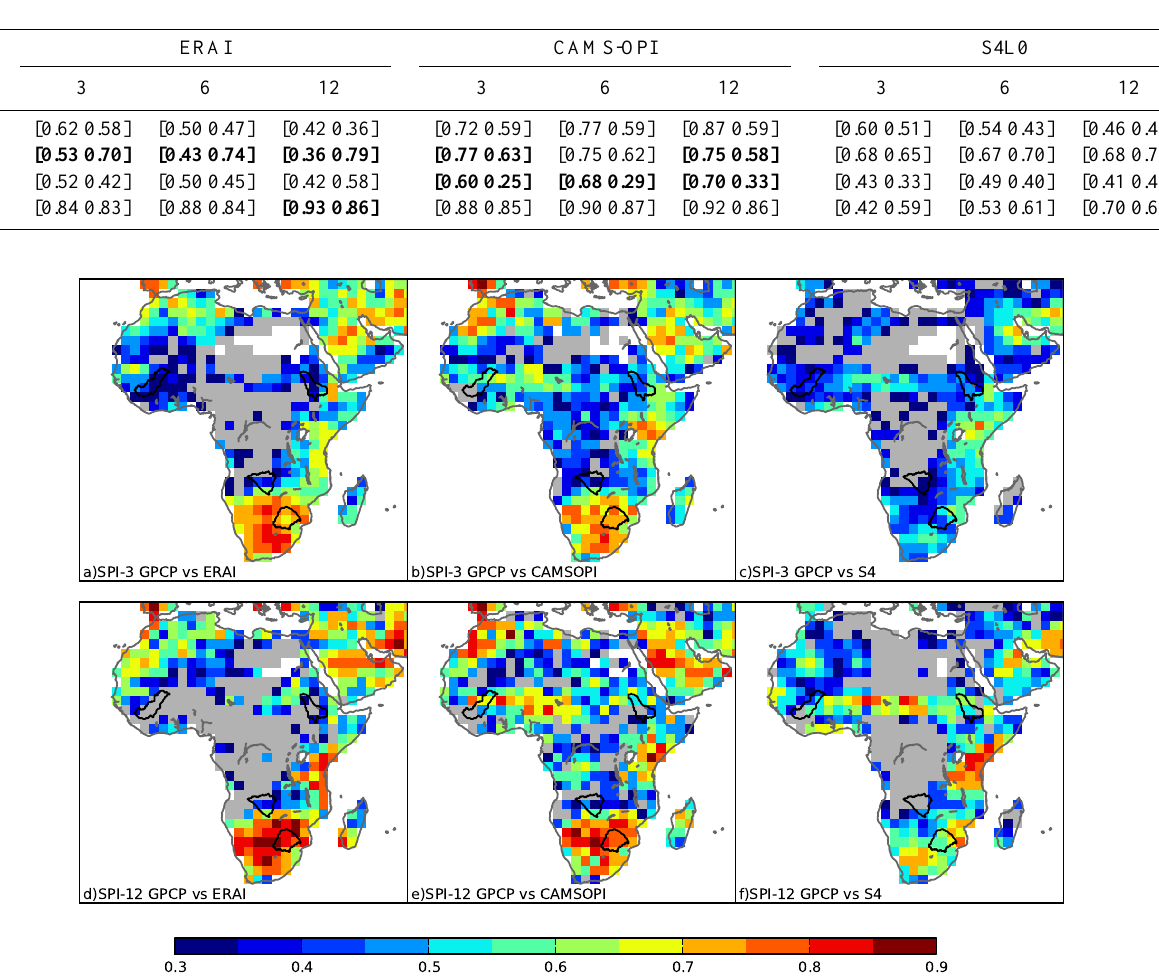
Table 3. Temporal correlation of the GPCP 3-, 6- and 12-month SPI and ERAI, CAMS-OPI and S4L0 (each column) for the different basins. The correlations between [c1 c2] indicate the correlations in the first half of the record (c1: 1979 to 1994) and second half of the record (c2: 1995 to 2010). The bold values indicate that the difference between c1 and c2 is statistically significant at 99% (using a Fisher transformation).